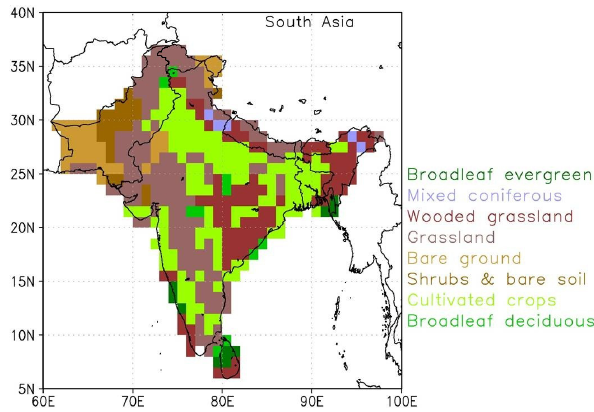
Fig. 1. Landmass selected for the RECCAP South Asia region following the definition of the United Nations and by accounting for the similaritiesinvegetationtypesasshownbythecolouredmapat 1 × 1 o spatialresolution(DeFriesandTownshend,1994).